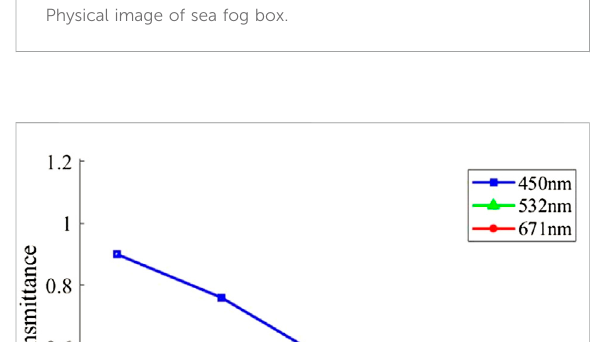
FIGURE 11 Physical image of sea fog box.